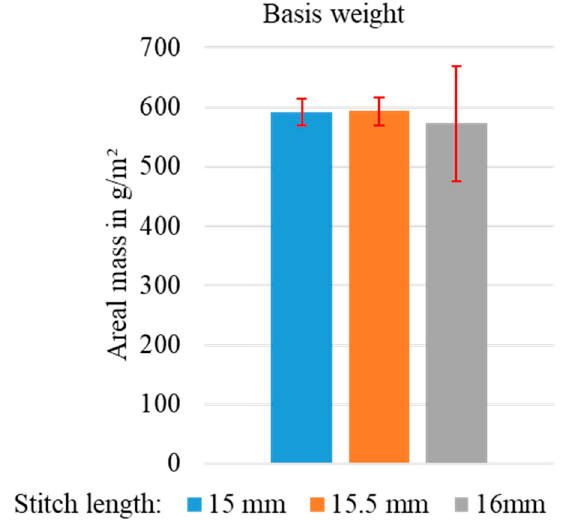
Figure 4. Basis weights of rCF multilayer weft knitted fabrics with dependence on stitch length.